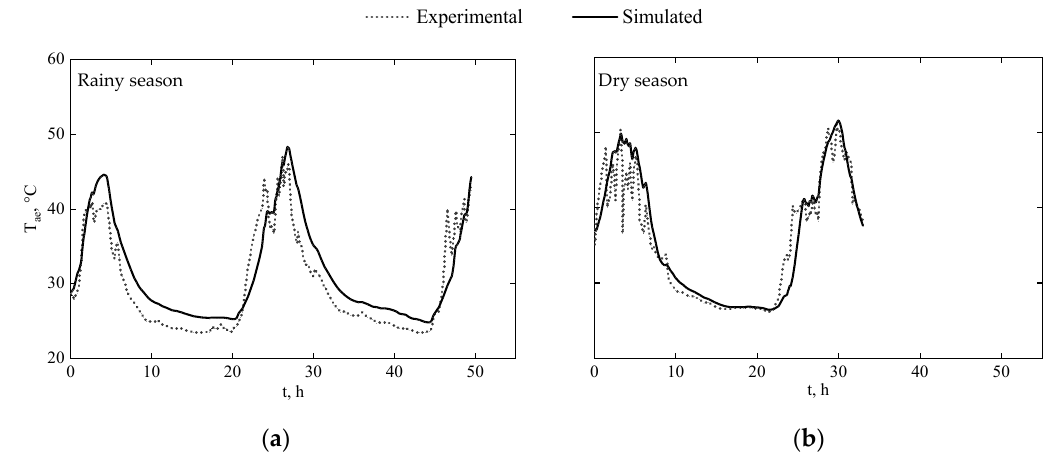
Figure 9. The experimental and simulated exit temperature T ae surface during the rainy season (22 November 2012) ( a ) and the dry season (4 June 2012) ( b ).